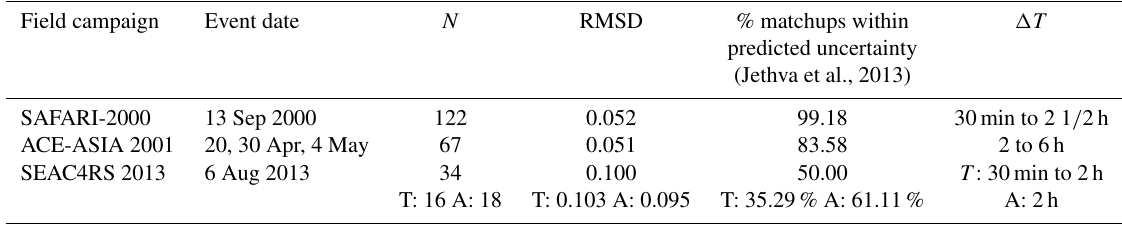
Table 2. Statistical summary of the MODIS vs. airborne above-cloud AOD comparison. Field campaign